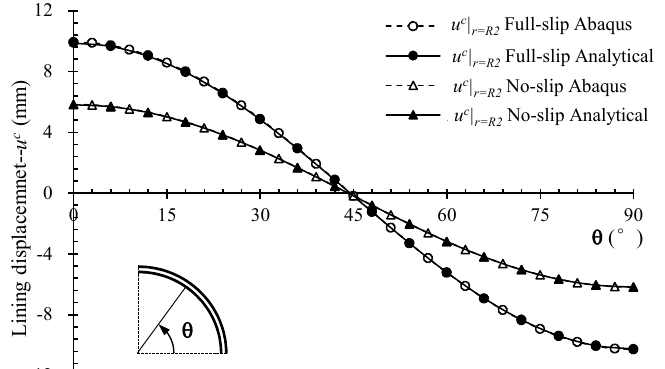
Figure 8. Comparison of the lining displacement evaluated by FE and analytical solutions with different concrete-steel interface properties.